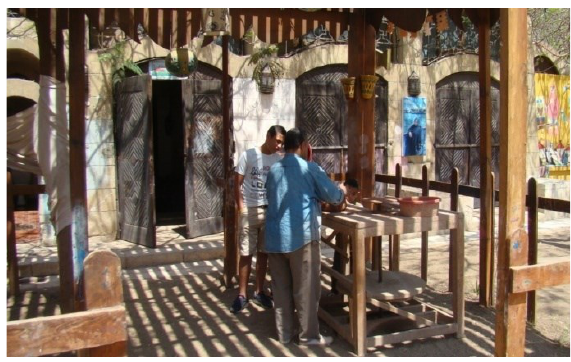
Figure 12. Activities Inside the Park, Authors,